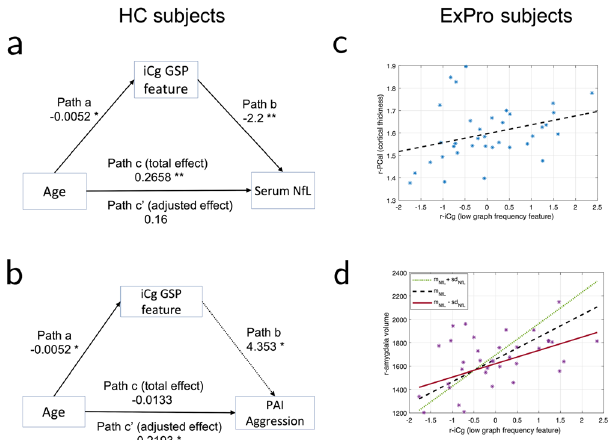
Fig. 4 Clinical and neurological interpretations for GSP features based on mediation and moderation analyses. (** p value < 0.01, * p value < 0.05, all p values were FDR corrected for multiple comparisons) a Mediation path diagram with GSP feature as mediator, age as predictor and serum NfL level